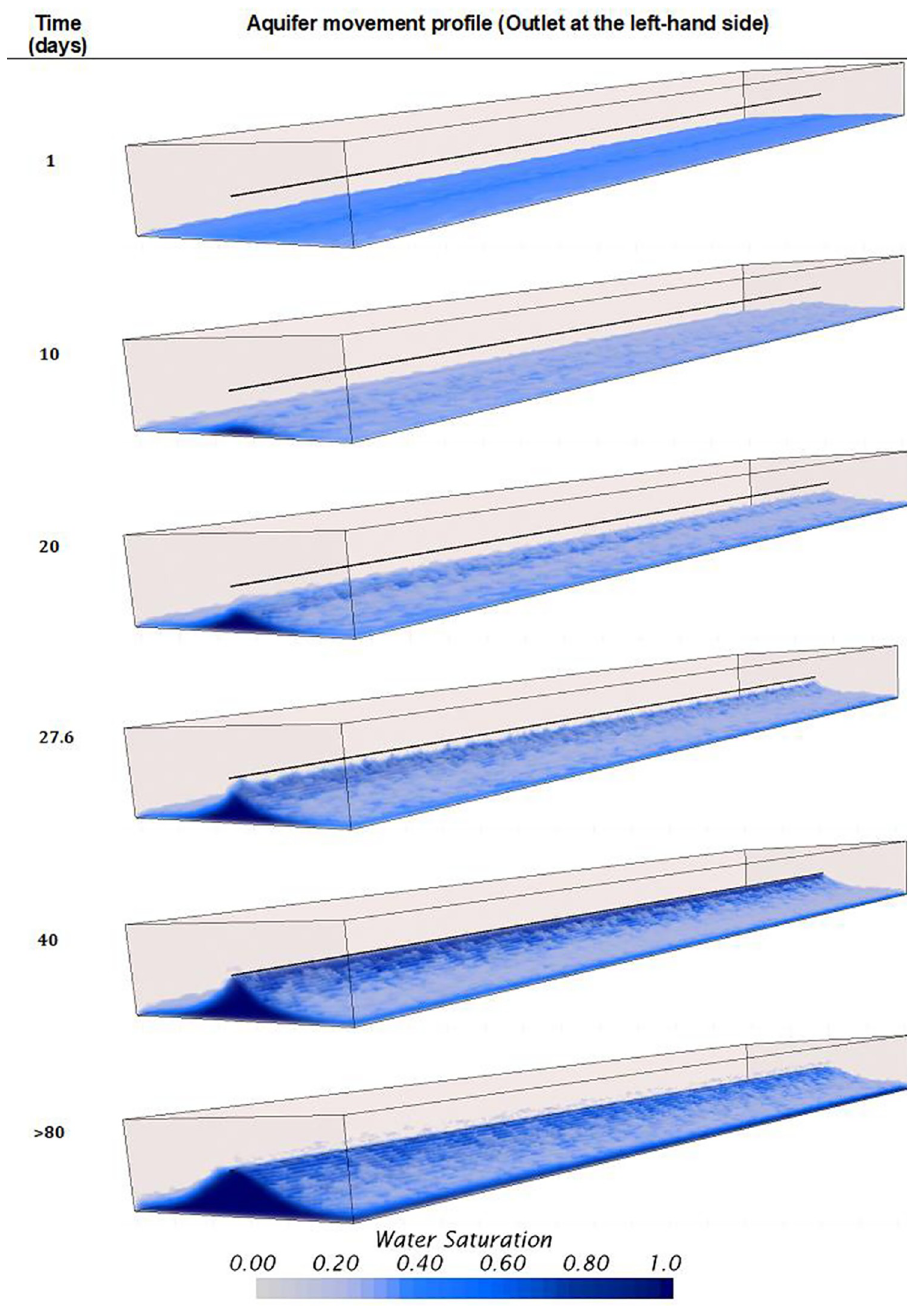
Fig 12. Aquifer movement profile obtained or the homogeneous